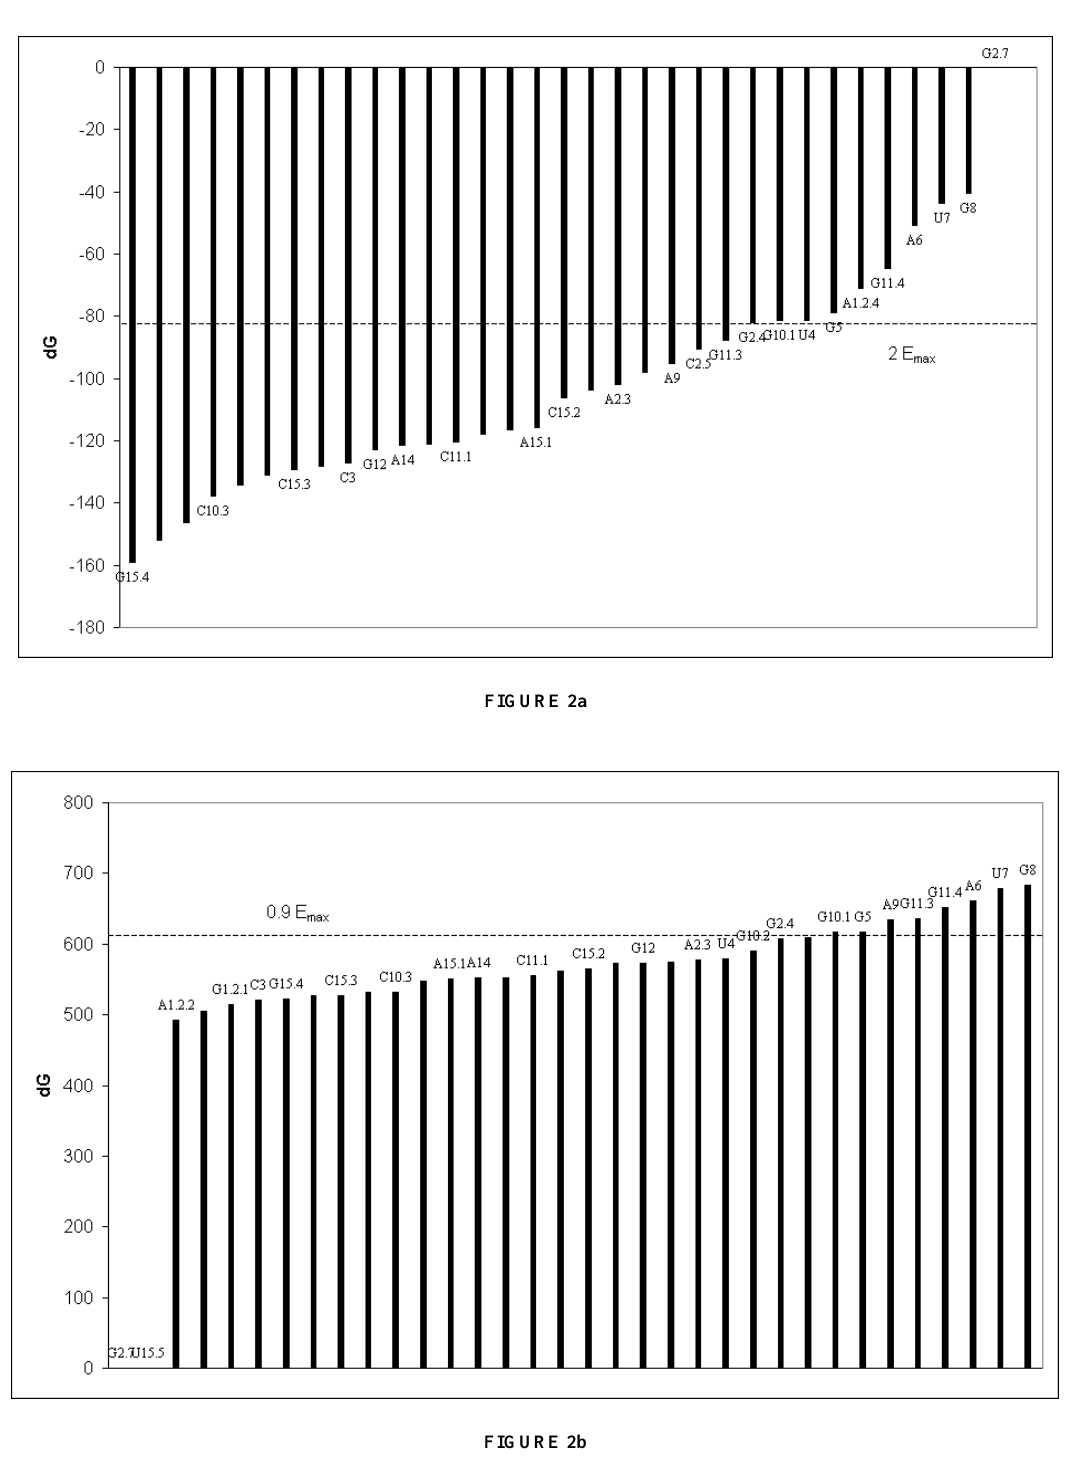
FIGURE 2 . A comparison of the results of the various methods of calculation, on the example of hammerhead ribozyme. Energy histograms are shown, approximate locations of the energy cut-off levels are marked with dotted lines. The right part of a histogram corresponds to higher energy values. (a) Explicit solvent and explicit counterions, cut off 2E max ; (b) implicit solvent and implicit counterions model (“standard” model for this study), 0.9 E max cut off; (c) an example of an energy histogram for a protein: PMI (phosphomannose isomerase, PDB 1pmi), ~450- residues. In PMI, all of the residues with the highest energies (“most destabilizing”) were in a very narrow region (on the right). All of the residues marked in bold in the figure are known to be functional (with only one "false positive"-His-54). For RNAs the energy histograms, as seen in the above examples, tend to be more continuous and usually lack the sharply distinct narrow regions (of the highest